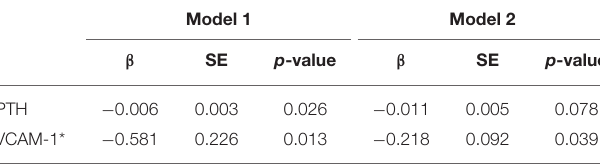
Model 1: Adjusted for eGFR. Model 2: Adjusted for eGFR, age, history of hypertension and diabetes, sex, albumin, and hemoglobin. eGFR, Estimated glomerular filtration rate; SE, standard error.